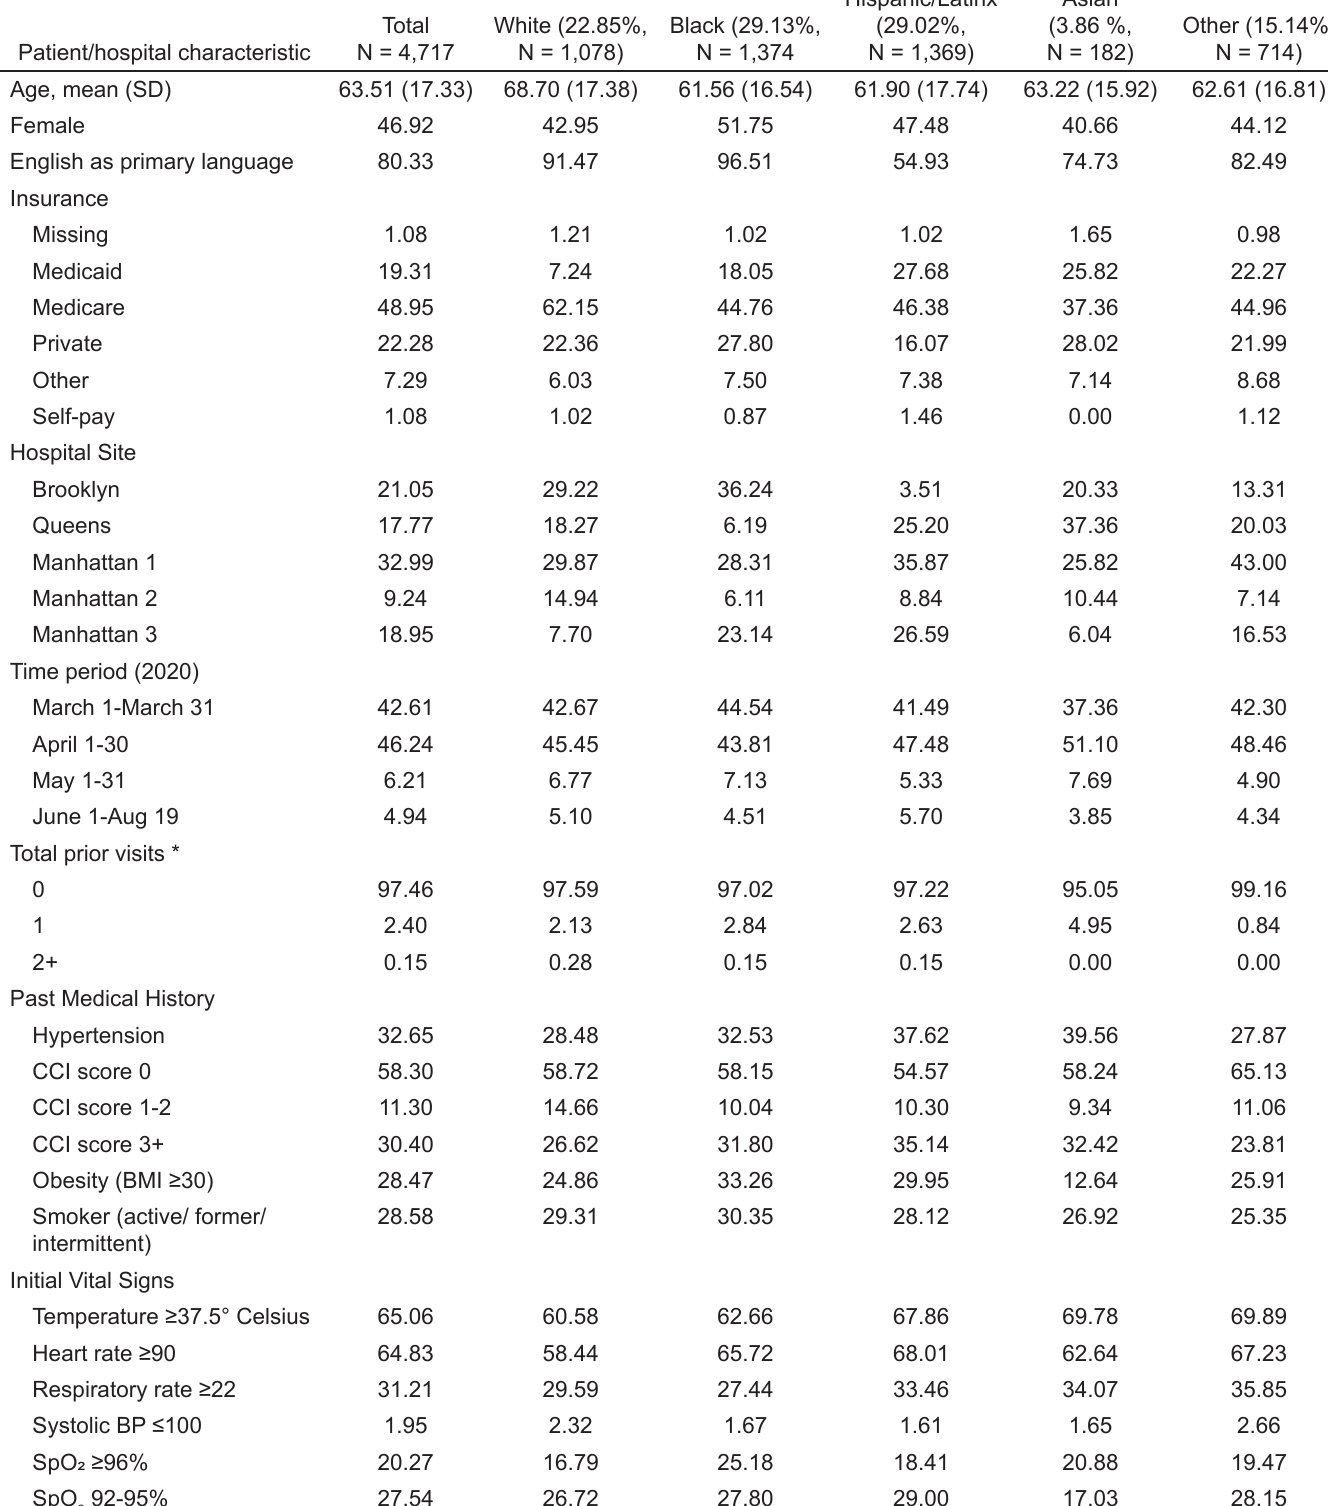
Table 1. Characteristics of study sample by race and